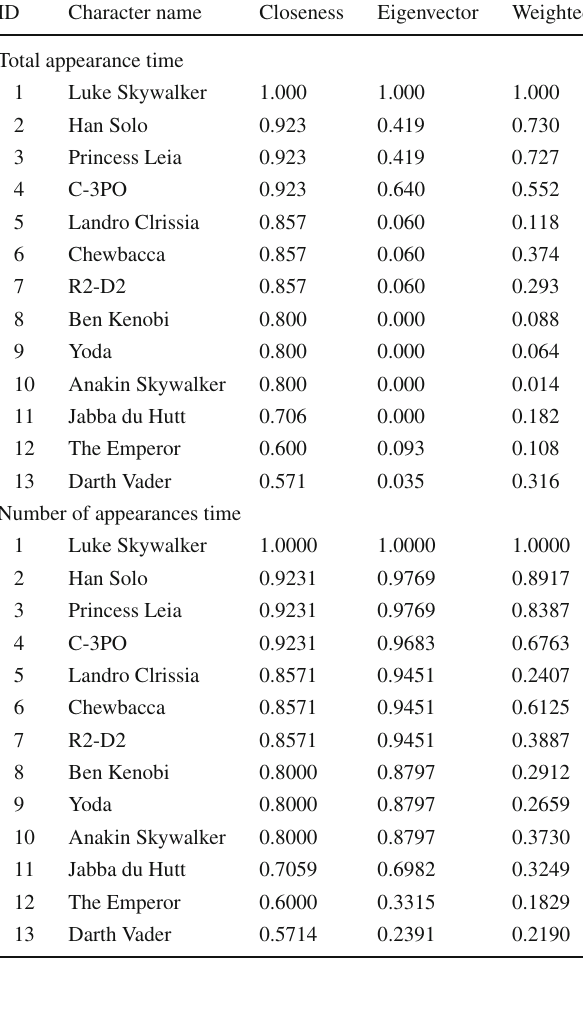
Table 1 The centralities measurement of the Star Wars VI